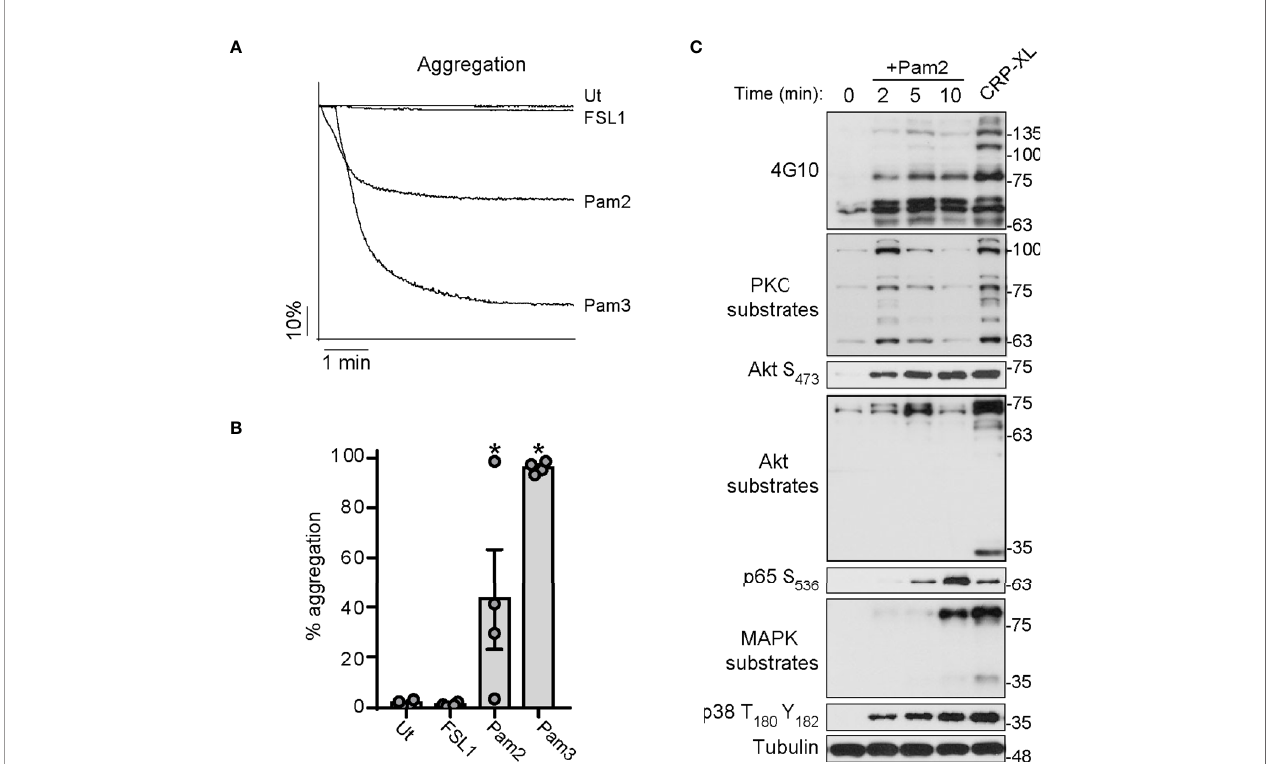
FIGURE 2 | Pam2CSK4 is weak to induce aggregation but triggers the activation of several signaling pathways in platelets. (A, B) Washed platelets (3×10 8 /ml) were stimulated with the indicated ligands and monitored under continuous stirring at 1200 rpm at 37°C for 6 minutes in an aggregometer. All the ligands were used at 10 µg/ml. (A) Traces of a representative experiment are shown. (B) Data are presented as the average of total percentage of aggregation for n=4 different experiments. (C) Human washed platelets (1x10 9 /ml) were stimulated with Pam2CSK4 (10 µg/ml) for the indicated times or CRP-XL at 2 m g/ml for 5 min. Cell lysates were analyzed by Immunoblot for the indicated antibodies. Representative blots from n=4 independent experiments are shown. * indicates statistical signi fi cance (p<0.05) compared to Untreated (Ut). Error bars indicate standard error of the mean